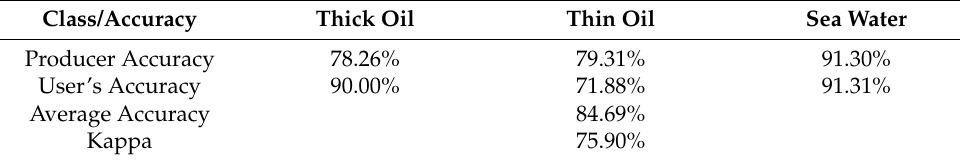
Figure 16. Random forest classification result graph and variable importance ranking for Case 3. Table 5. Classification accuracies of random forest classifier in Case 3. Class/Accuracy